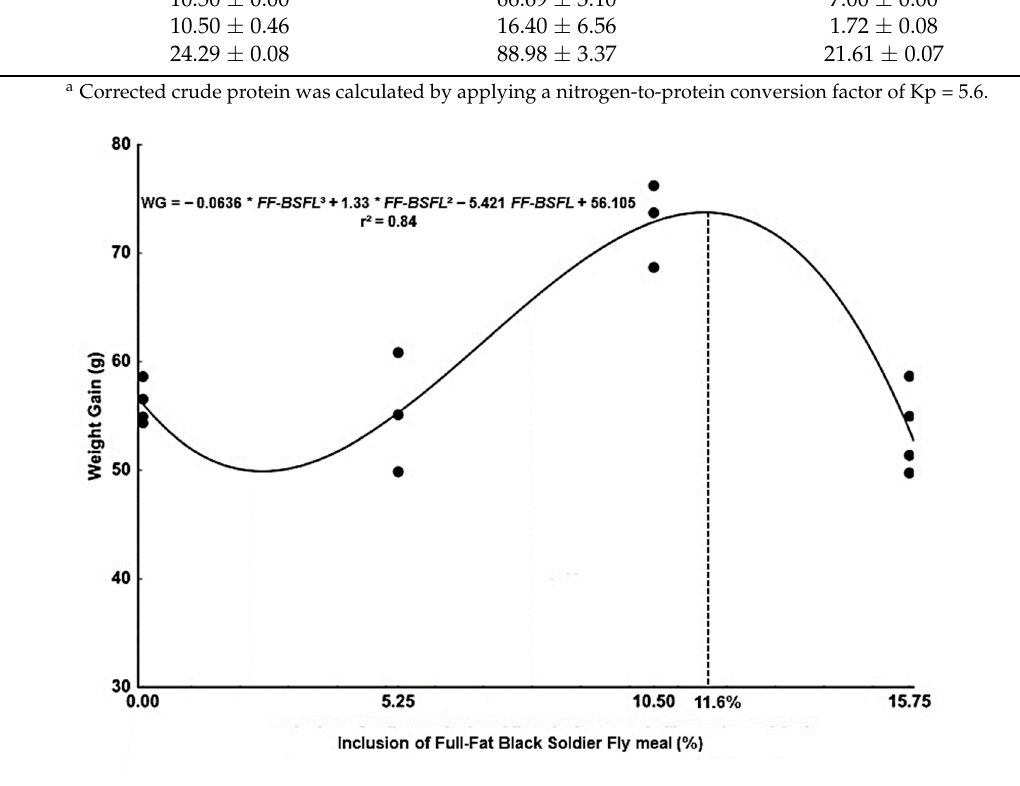
Figure 1. Weight gain of tambaqui juveniles fed diets containing increasing levels of full-fat black soldier fly (FF-BSFL) meal.